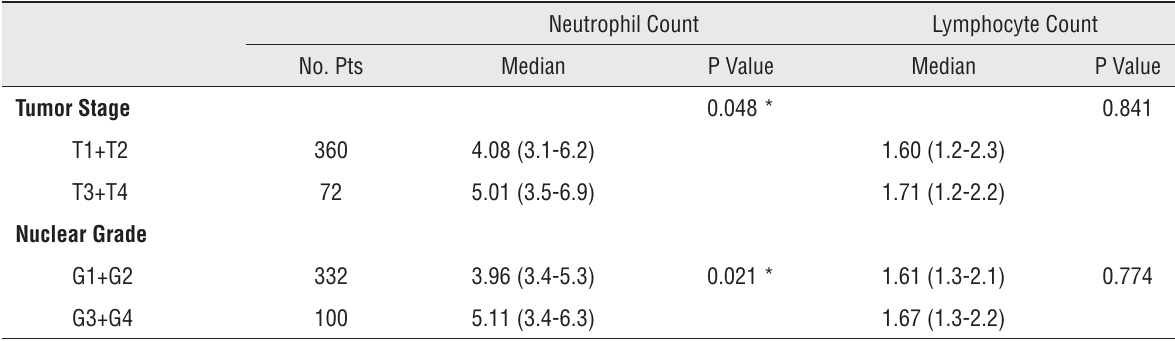
Table 3 - NC, LC and NLR associations with pathological